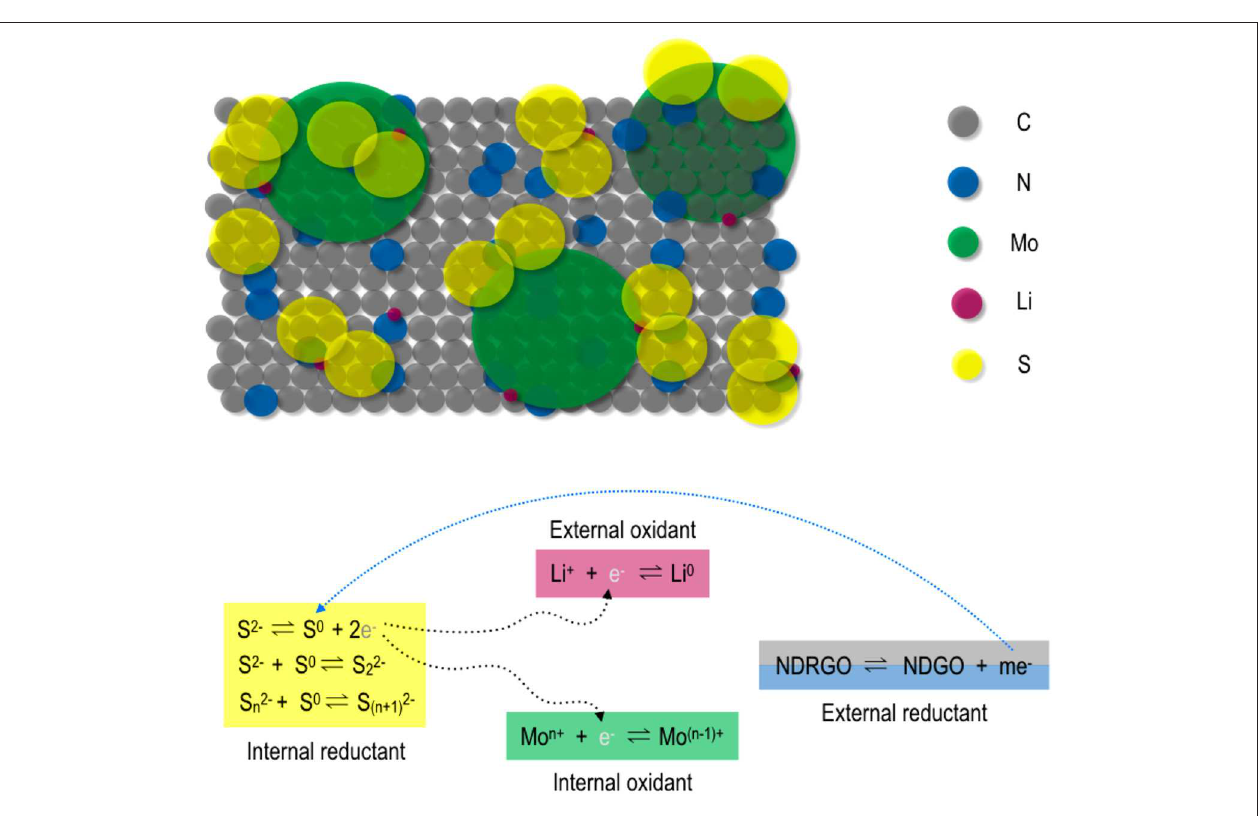
2 Electrons. So the question is the entire process is taking place if one can conceive the idea that in a molecule of lithium sulfide, + if lithium ion is treated as external oxidant and sulfide as the 2